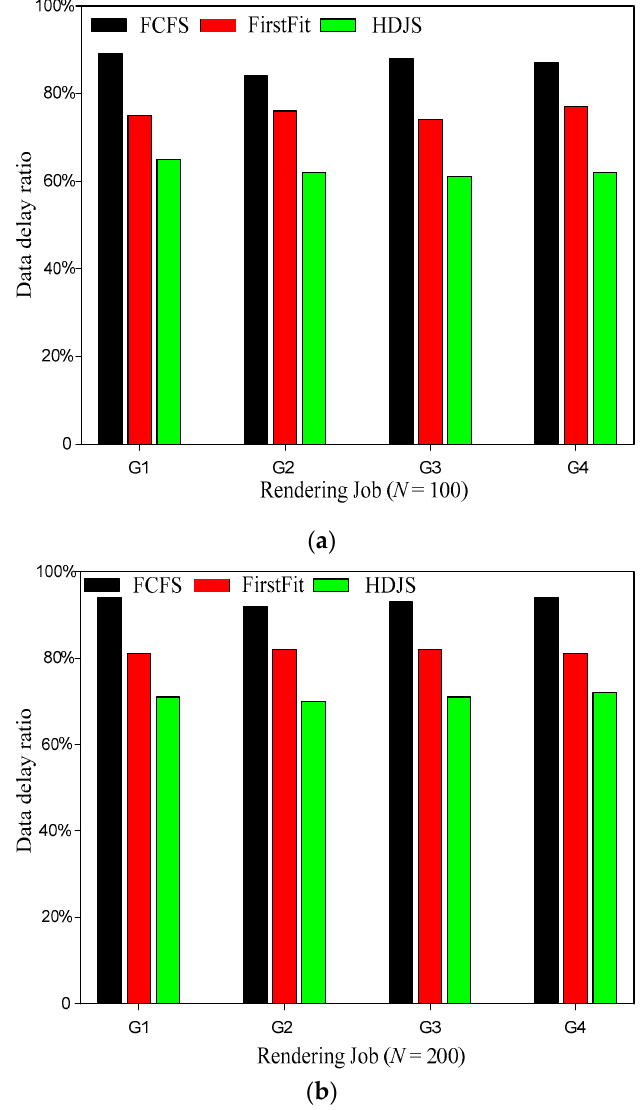
ff erent strategies; ( a ) N = 100; ( b ) N =